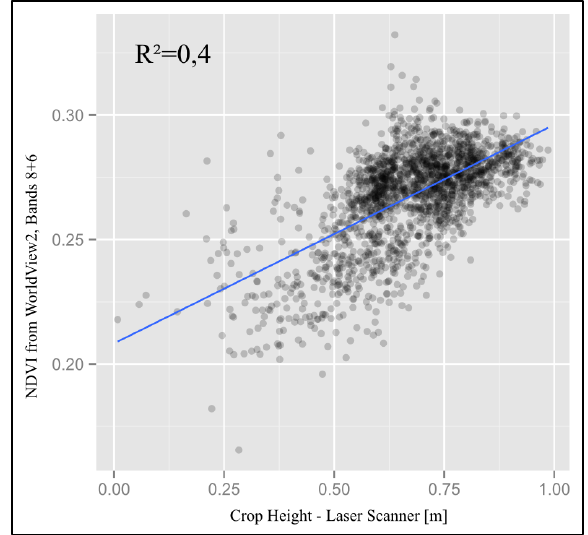
Figure 6. Correlation of NDVI from WorldView-2 (July, 7 th ) and CSM-derived plant height from July, 3 rd (N=1857)